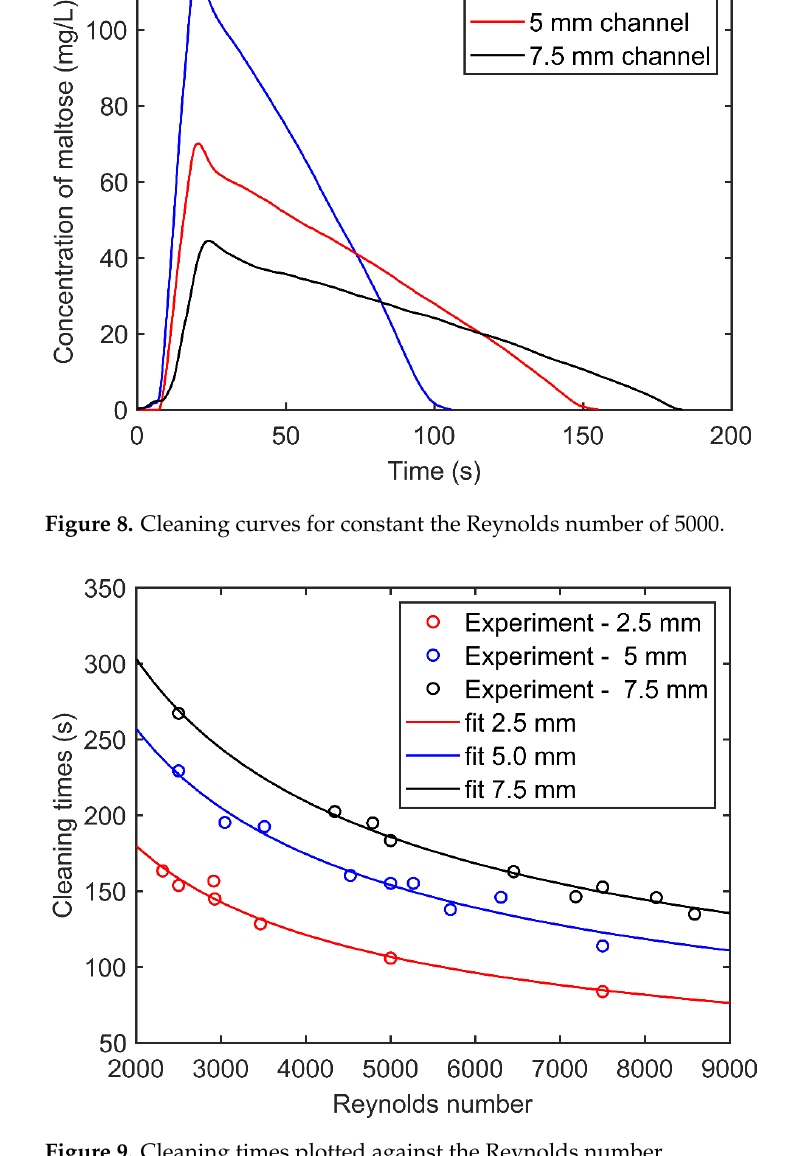
Figure 9. Cleaning times plotted against the Reynolds number.